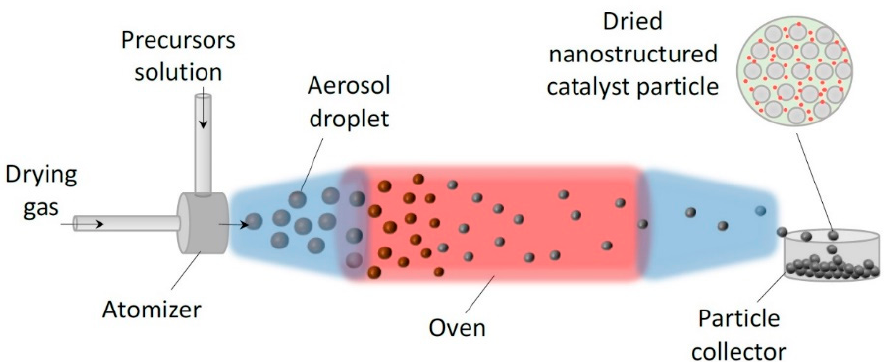
Figure 4. Schematic view of the AASG process that can be operated in a continuous mode for the one-pot production of nanostructured catalysts. The precursor solution contains a solvent, metal precursors, and a templating agent (e.g., a surfactant that will form micelles via evaporation-induced self-assembly, EISA). The droplets formed by atomization are transported in a drying gas towards a drying zone where the formation of structured particles takes place. Reprinted with permission from ref. [121]. Copyright 2020 Wiley.